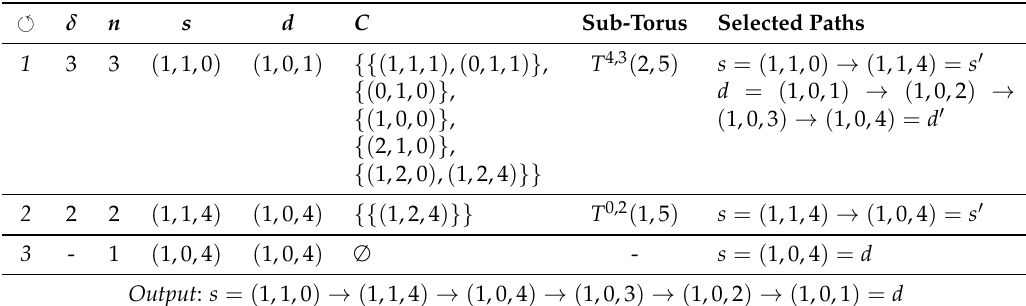
Table 1. A sample execution trace of the algorithm for a non-trivial routing example in a T ( 3,5 )